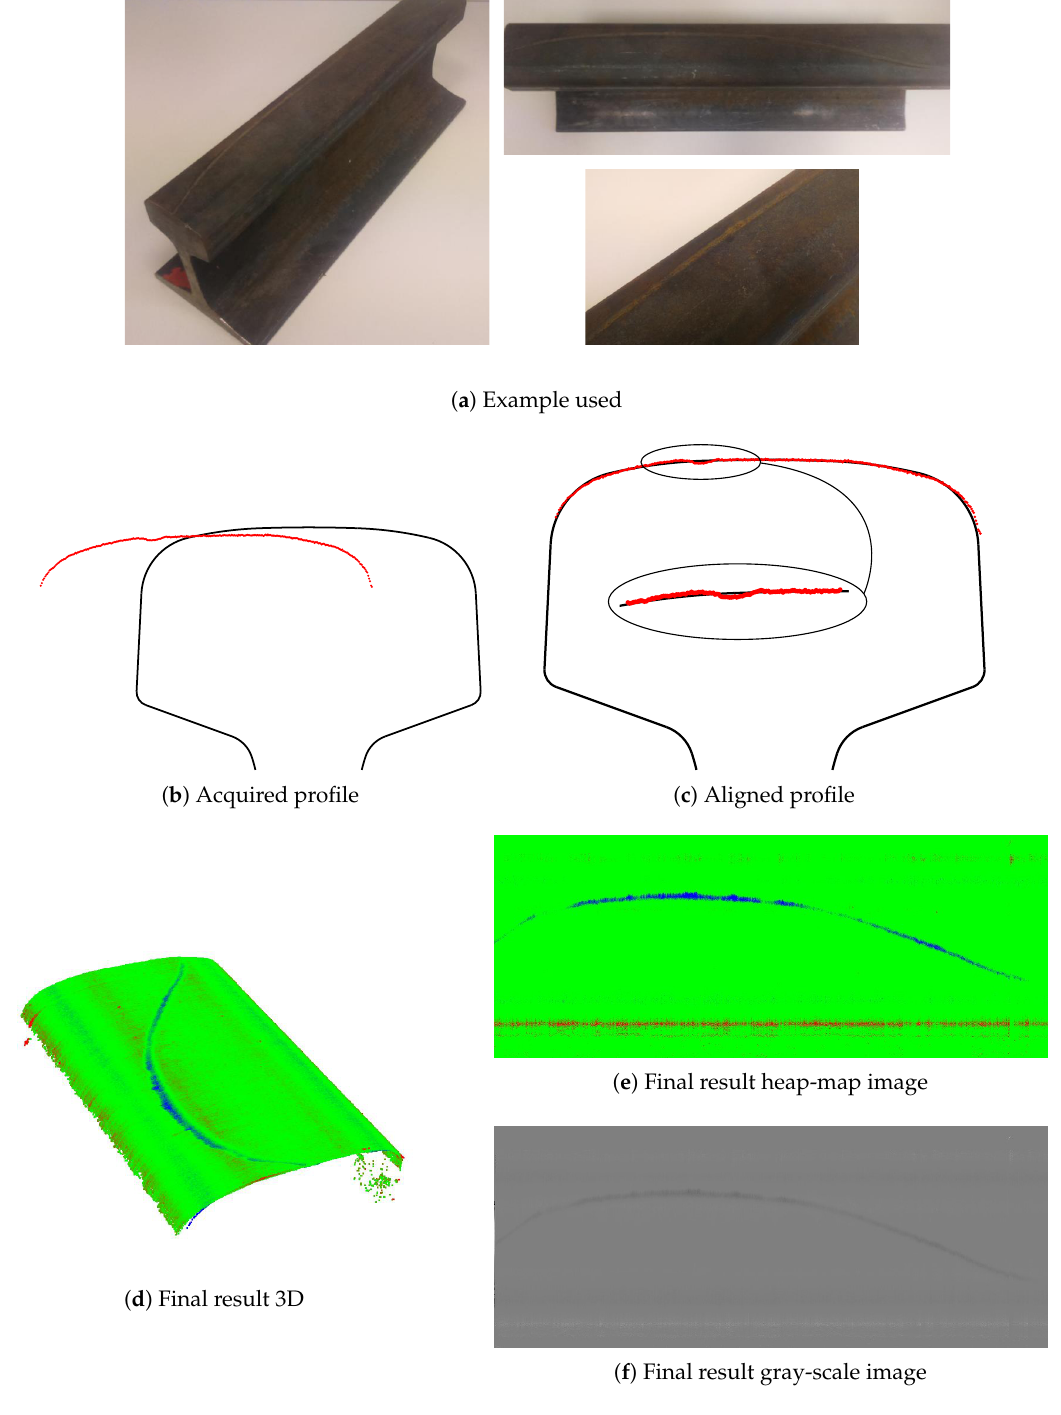
Figure 10. Acquisition and representation example of a real surface